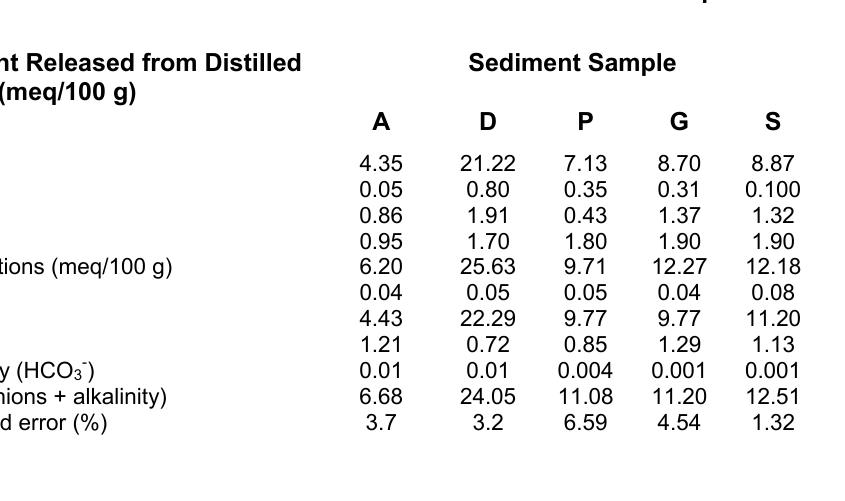
Soluble and Exchangeable Ions